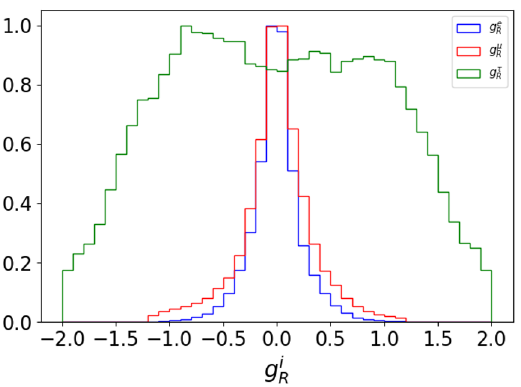
Figure 9 . Distributions of the couplings g i Carlo